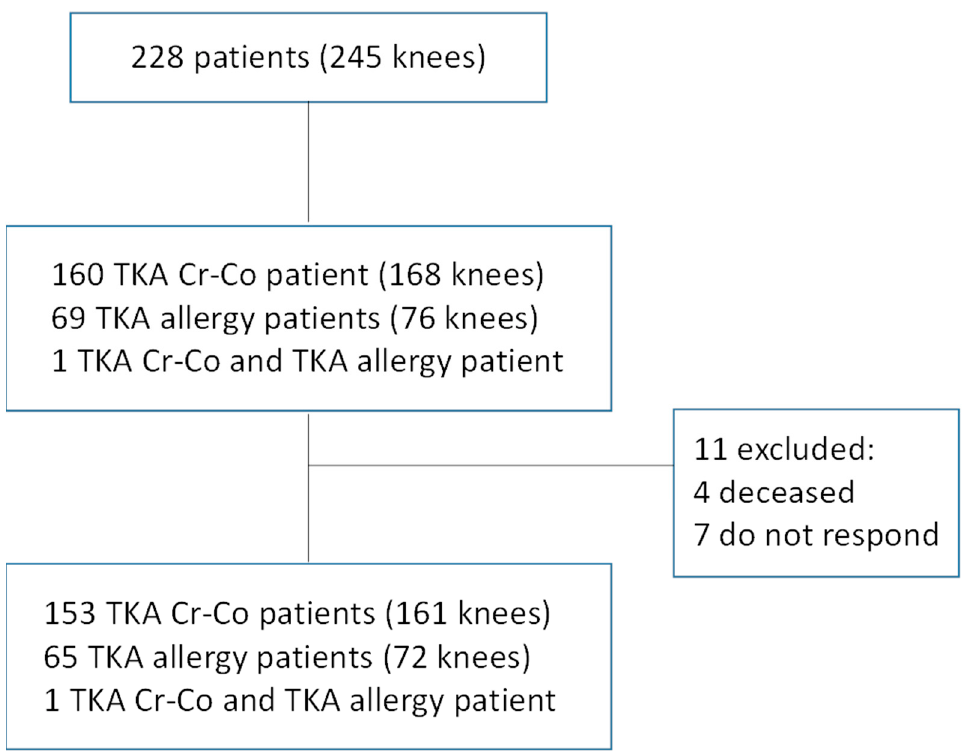
Figure 1. Patient flow chart. Total knee arthroplasty (TKA).